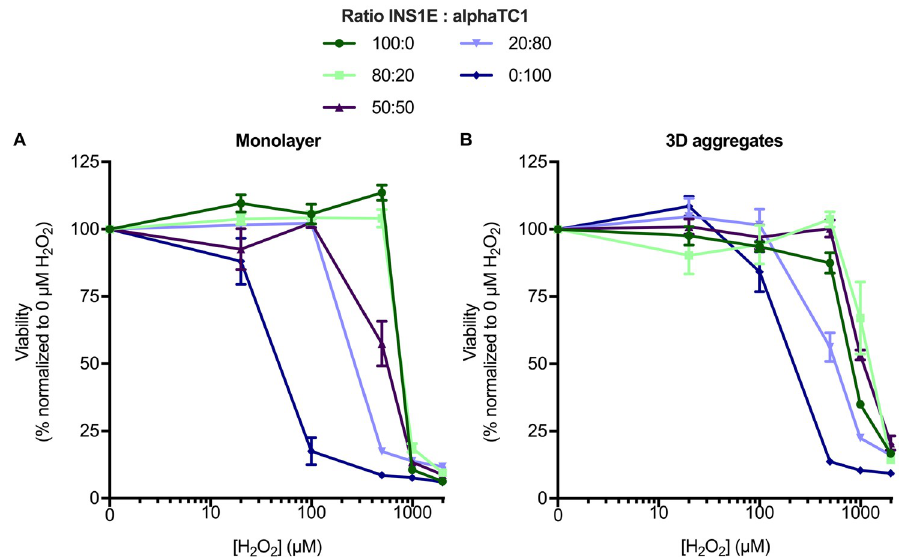
Fig 1. Cell viability in monolayer and 3D aggregate cultures after oxidative stress induced by H 2 O 2 . The percentage of viable cells is shown relative to the control that was not exposed to H 2 O 2 . A) In monolayer culture, the higher the percentage of INS1E cells included in the co-culture, the more H 2 O 2 was necessary to induce a similar decrease in viability. B) In 3D aggregates of 80:20 and 50:50 INS1E:alphaTC1, the cells were more resilient to the loss of viability caused by H 2 O 2 compared to the other ratios. N = 3, A) n � 1; B) n � 2 and data are presented as mean ± SEM; all p -values are shown in S1 and S2